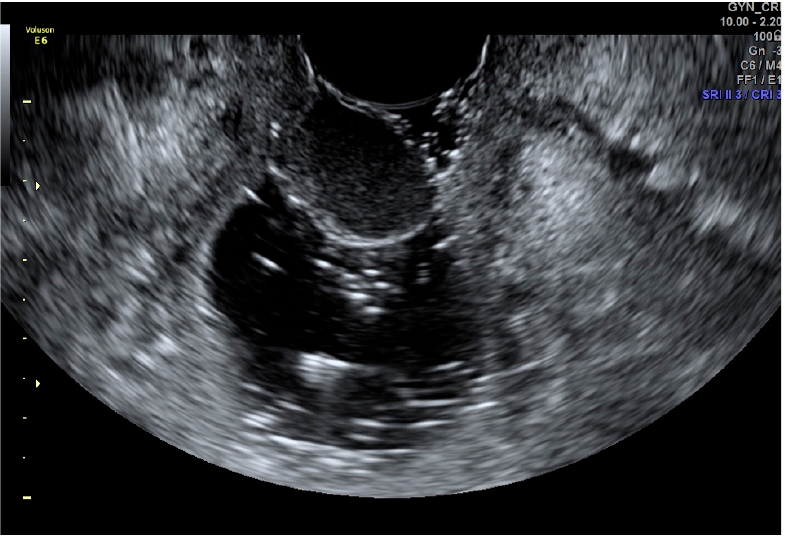
Figure 1. SVG image of a vaginal cyst.